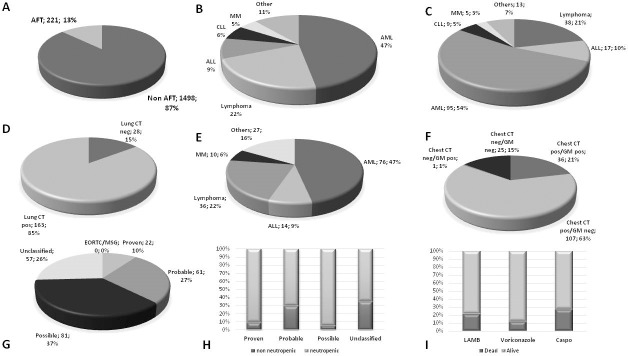
Clinical characteristics, diagnostic procedures, EORTC/MSG classification, distribution of AFT and association with outcome.(A) Proportion of patients undergoing or not undergoing to AFT. (B) Diagnoses among the group of patients undergoing AFT. (C) Distribution of neutropenia in the patients undergoing to AFT. (D) Proportion of lung CT scans positive and negative in the patients undergoing AFT. (E) Distribution of positive lung CT scan across the different diagnoses. (F) Distribution of GM and lung CT scan positivity/negativity. (G) EORTC/MSG classification of the AFT patients. (H) Distribution of neutropenia in the different EORTC/MSG classes. (I) Distribution of different antifungal agents among positive (alive) and negative (dead) outcomes.